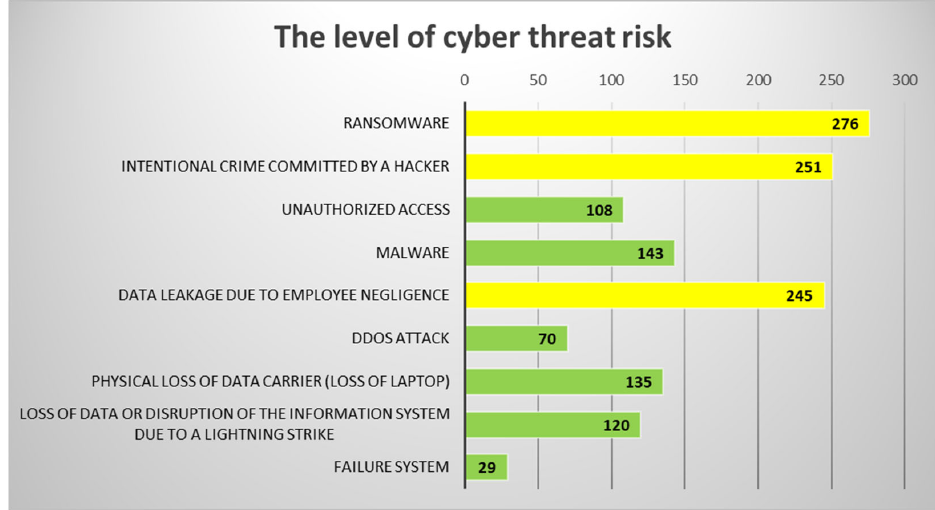
Figure 4. The level of cyber ‐ threat risk (own resource).